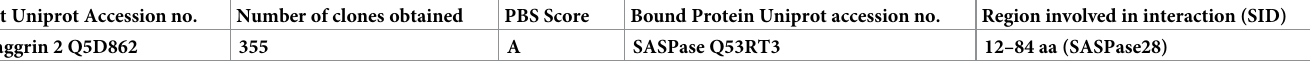
Table 3. FLG2Nter (aa 2–95) interacts with the N-terminus of SASPase 28 protein. A Y2H analysis using FLG2Nter (aa 2–95) as bait was used to screen 71 million clones in a random primed human reconstructed skin library. 355 out of 362 positive interactions represented sequences from SASPase (Q53RT3) with a PBS score class A and a SID domain between amino acids 12 and 84 in the N-terminal domain of SASPase 28. Bait Uniprot Accession no.